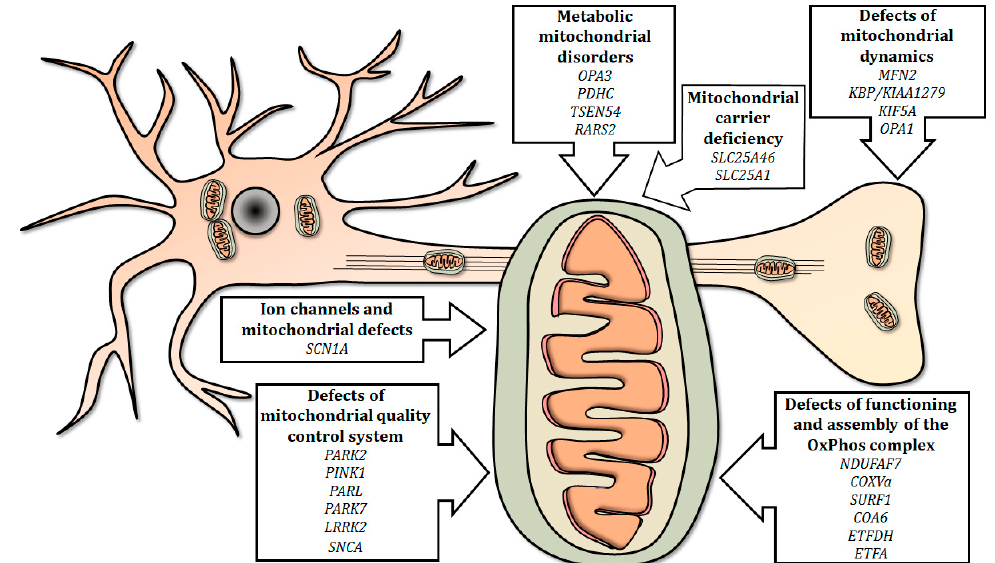
Figure 1. Summary of mitochondria-related genes involved in neurological human disorders, modeled in mutant zebrafish. Mutations in genes involved in mitochondrial electron transport chain, physiology, quality control, dynamics and metabolism, as well as mutations in selected genes encoding carriers and ion channels, can disrupt the integrity of the mitochondrion and / or influence its functions, thus determining the onset of neurological disorders.